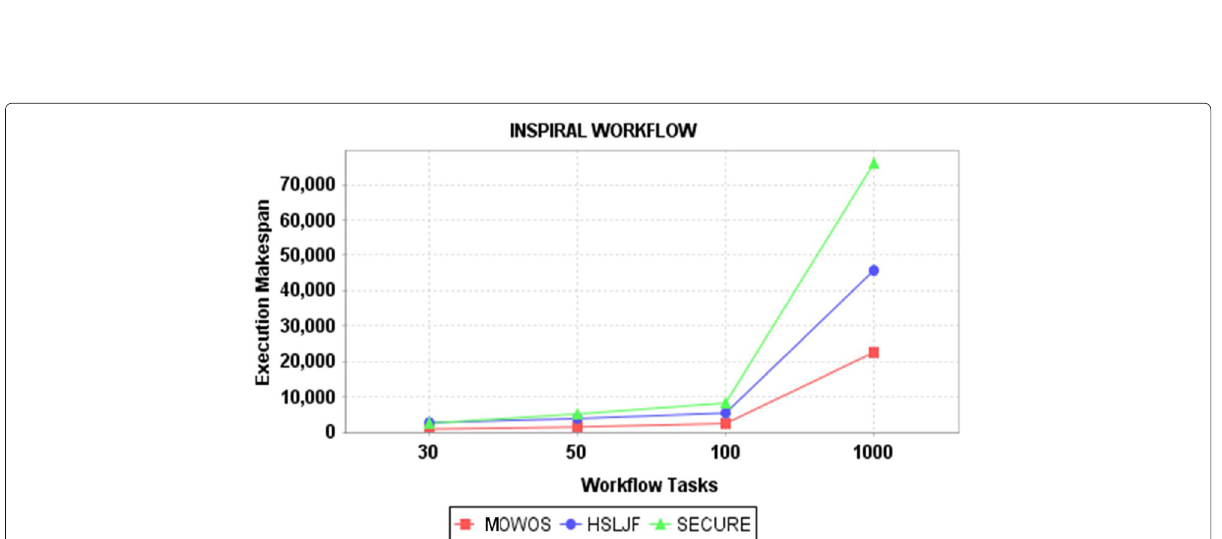
Fig. 12 Makespan results of Inspiral workflow